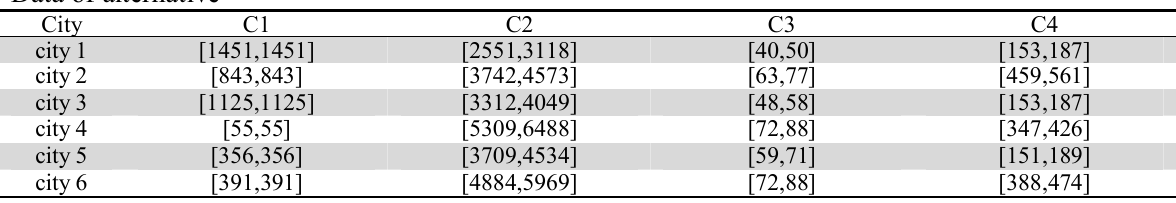
The normalized rates